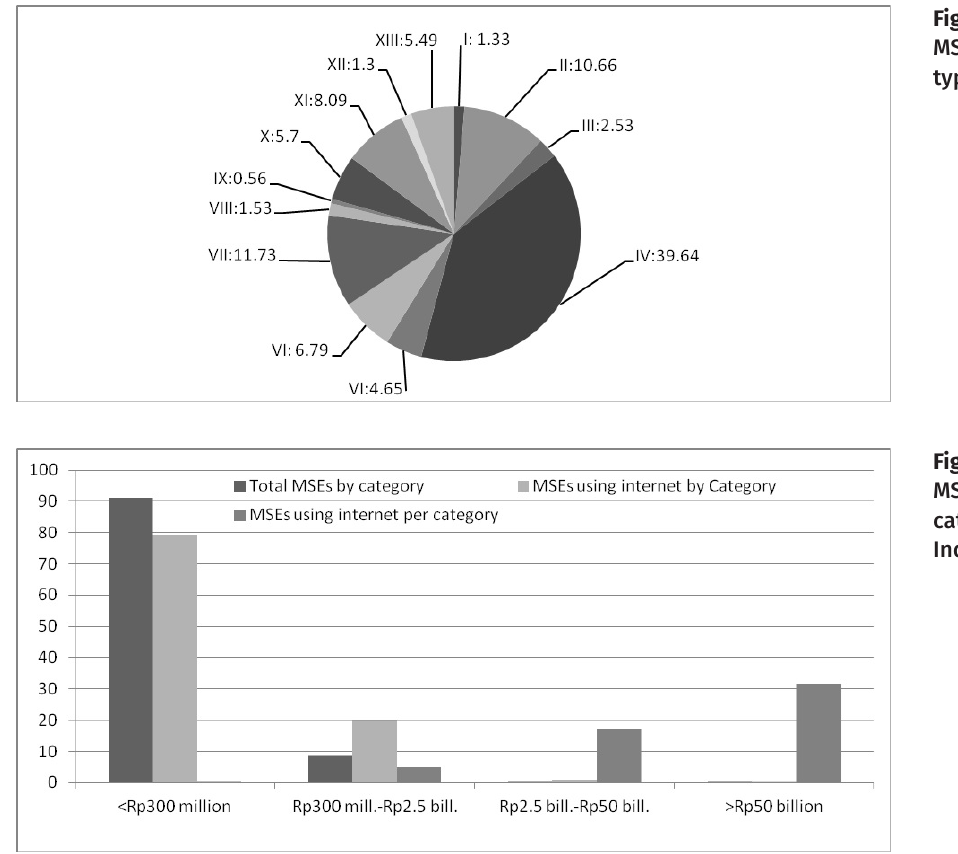
Figure 9. Distribution of MSEs using internet by type of business, 2016.